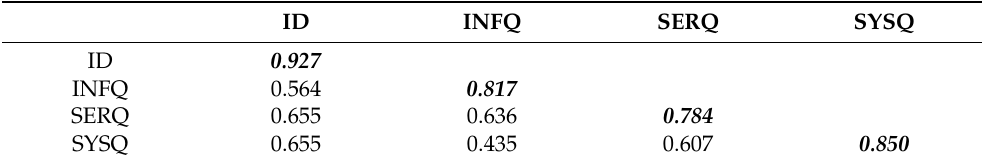
Table 3. Correlations of constructs and the square root of the AVEs.